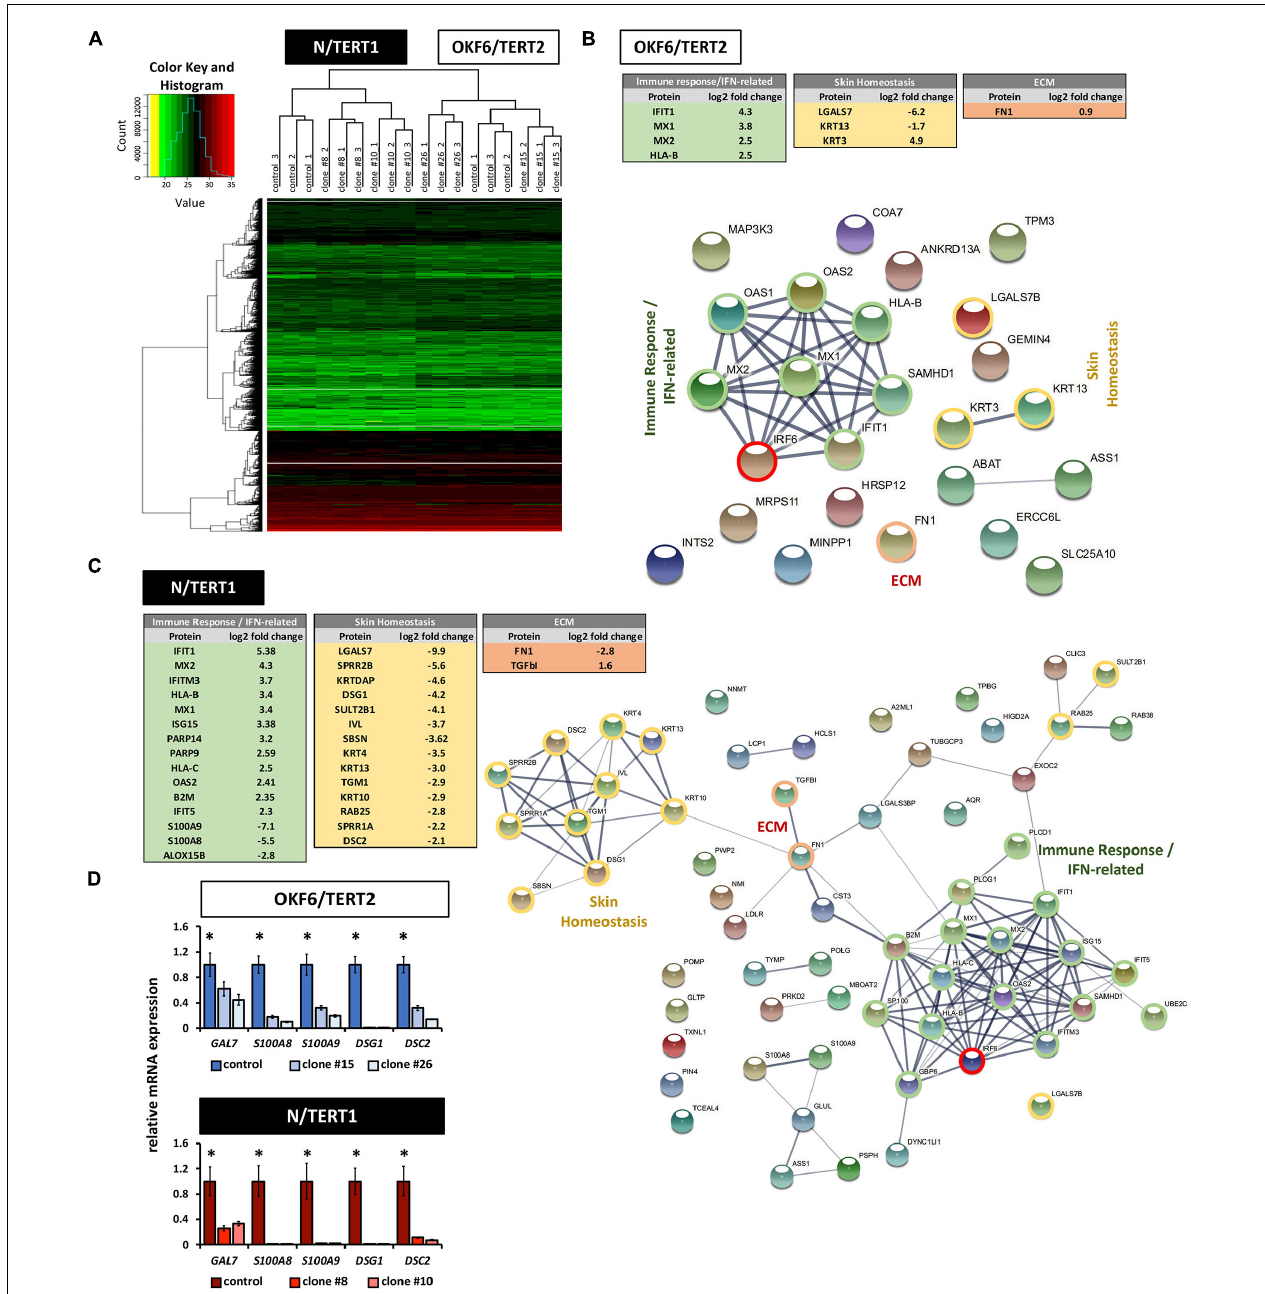
FIGURE 7 | (A) Heat map of hierarchical clustering after imputation and color key represent the total amount of identified proteins in N/TERT1 (left side) and OKF6/TERT2 samples (right side). Note the hierarchical clusters on top demonstrating significant changes in the proteome between skin- and oral mucosa-derived cell lines. (B) Differentially expressed proteins in OKF6 clone #26 vs. OKF6 control in cultures at high cell density (HD). Tables on the top summarize the main three protein clusters: immune response/IFN-related (green), Skin Homeostasis (yellow), and ECM (red). String network depicting all differentially expressed proteins is shown as well with the three main clusters as described before. Note that only proteins are shown having a differential expression of at least log 2 fold change = 1. ECM: extracellular matrix. (C) Differentially expressed proteins in N clone #10 vs. N control in cultures at high cell density (HD). Tables on the left summarize the main three protein clusters: immune response/IFN-related (green), Skin Homeostasis (yellow), and ECM (red). String network depicting all differentially expressed proteins is shown as well with the three main clusters as described before. Note that only proteins are shown having a differential expression of at least log 2 fold change = 1. ECM: extracellular matrix. (D) qPCR verifications for some mRNA transcripts ( GAL7 , S100A8 , S100A9 , DSG1 , and DSC2 ) for which the corresponding proteins have been found to be differentially expressed in both OKF6 and N cells compared to the corresponding IRF6-deficient keratinocytes. ∗ p < 0.05 controls vs. clones #15 and #26, and clones #8 and